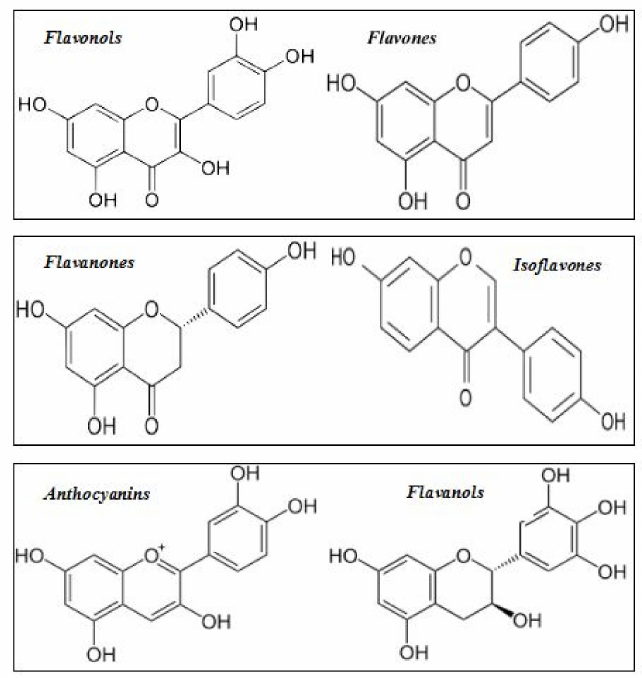
Figure 1. Examples of flavonoid